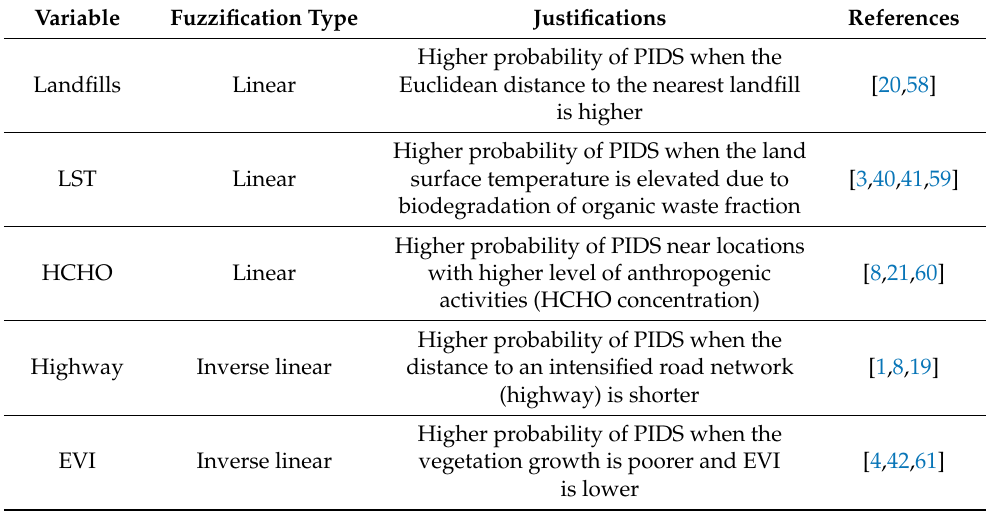
Table 3. Types of different fuzzification methods applied to each of the five